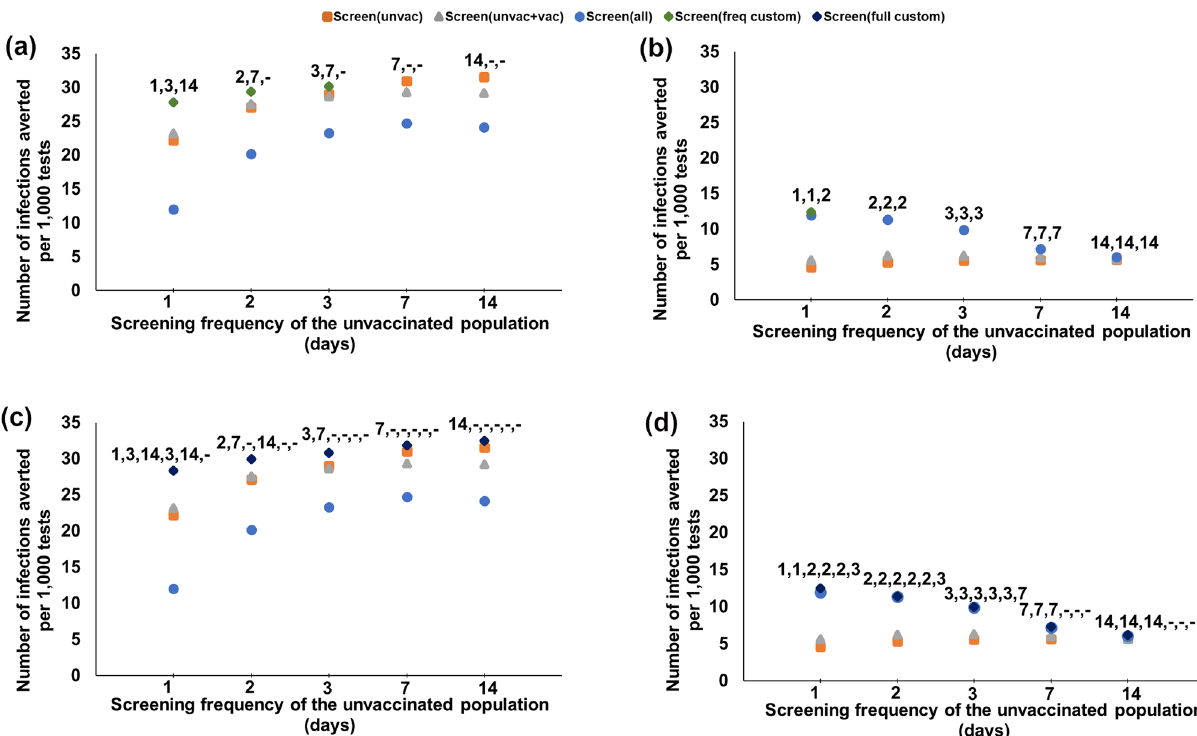
Figure 3. Number of infections averted per 1000 tests with respect to the screening frequency of the unvaccinated, for various customized screening strategies under 64% boosted, 18% vaccinated, 18% unvaccinated, and various Omicron proportions. ( a , b ) Screening is customized based on vaccination status only; the label represents the screening frequency for unvaccinated, vaccinated, boosted. ( c , d ) Screening is customized based on both vaccination status and faculty versus students; the label represents the screening frequency for unvaccinated students, vaccinated students, boosted students, unvaccinated faculty, vaccinated faculty, boosted faculty. (“–” indicates no